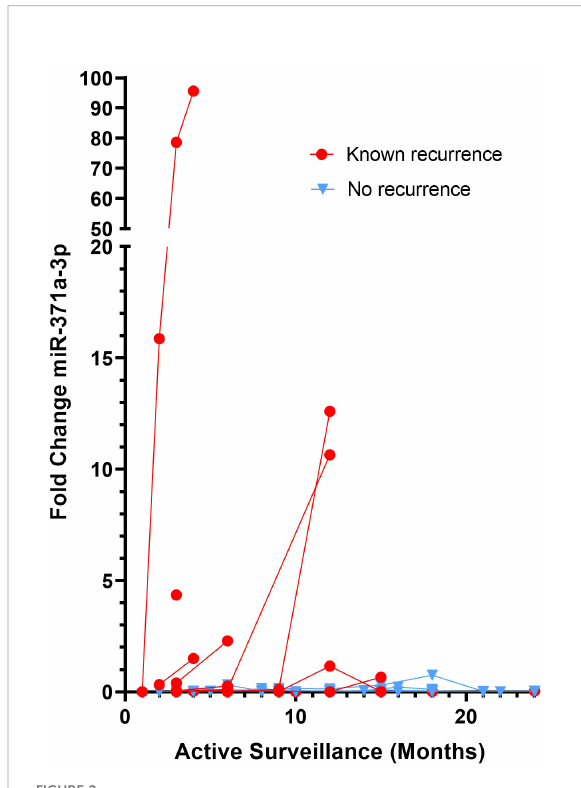
FIGURE 2 Seven of ten TGCT Patients with recurrence show elevated serum miR-371a-3p when adopting a protocol without pre- ampli fi cation. Sequential serum samples from Stage 1 TGCT patients undergoing active surveillance were analysed for serum miR-371a-3p via RT-PCR without a cDNA pre-ampli fi cation step. Patients with known recurrence (red dots) and known non- recurrence (blue triangles) are shown. FC calculated via relative expression to the endogenous housekeeper miR-30b-5p and to a control, no tumour cohort. FC>1.1 considered a positive value.